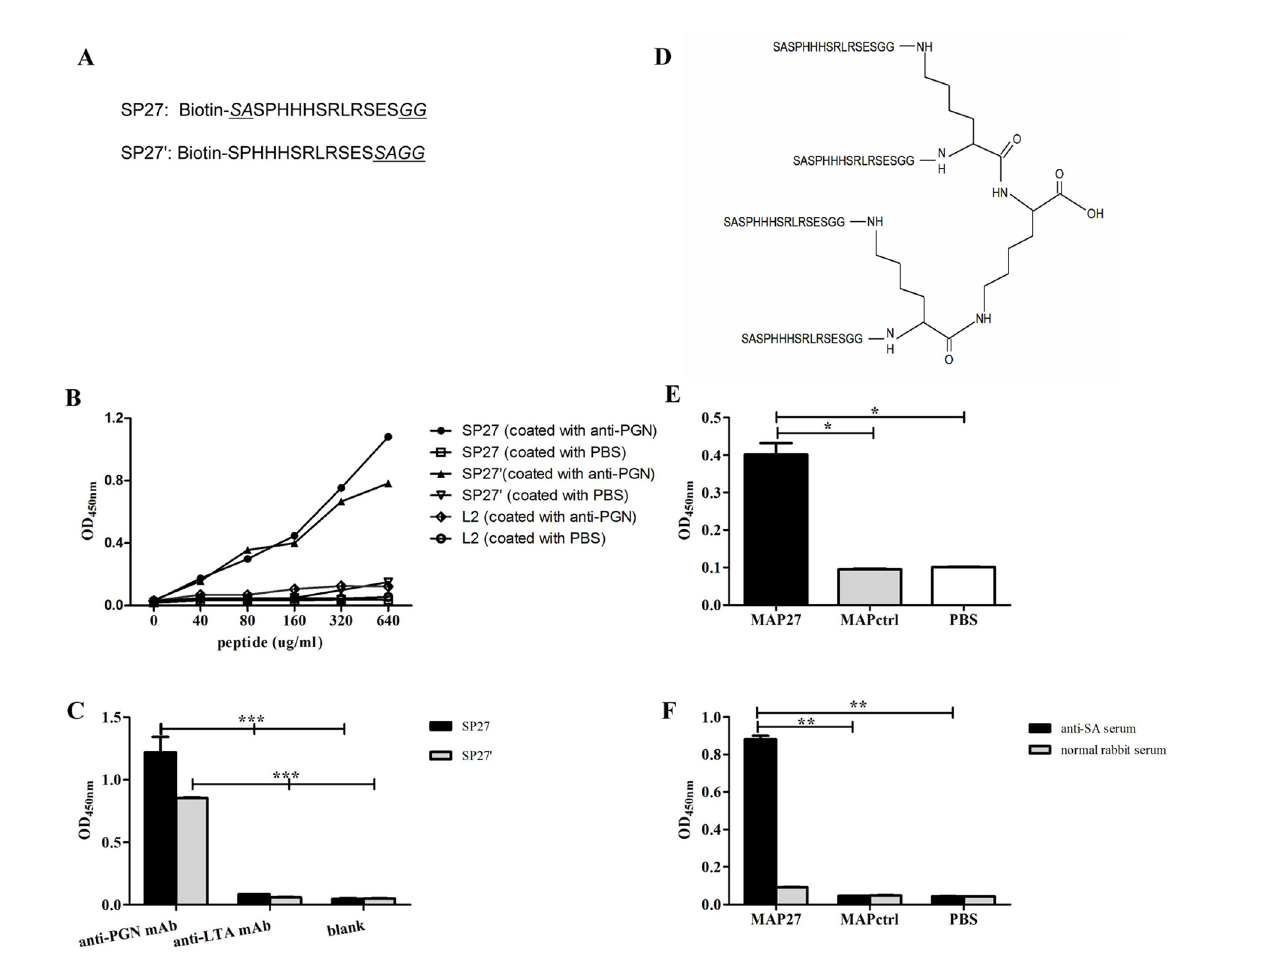
Fig 1. Both SP27 and MAP27 bind to anti-PGN mAb specifically. (A) The sequences of SP27 (Biotin- SA SPHHHSRLRSES GG ) and SP27 ’ (Biotin- SPHHHSRLRSES SAGG ). Underlined letters represent nonspecific flanking amino acids. (B) Both SP27 and SP27 ’ bind to anti-PGN mAb in a dose- dependent manner. (C) Both SP27 and SP27 ’ (100 μ g/ml) specifically bind to anti-PGN mAb, but not to anti-LTA mAb. For ELISA assays in panel B and C, anti-PGN mAb or anti-LTA mAb was used to coat the wells at a concentration of 5 μ g/ml, SP27, SP27 ’ or non-specific peptide L2 (in panel B, sequence: Biotin-HSGHWDFRQWWQPSGG) was then added at indicated concentrations and incubated at 37°C for 40 min, followed by detection with HRP-labeled streptavidin. (D) The structure diagram of MAP27. MAP27 was synthesized in a tetra-branched form that contains four copies of a